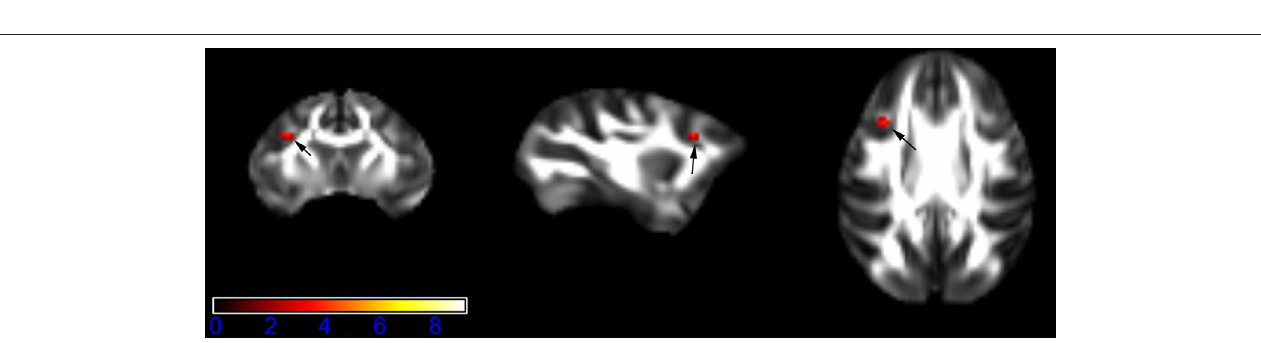
FIGURE 4 | Areas in middle temporal gyrus WM (MTG-WM, left side) with reduced fractional anisotropy values in the chronic ketamine exposure group compared to controls at p < 0.005 (in red; uncorrected). The anatomical underlay is DTI-based monkey brain image template (UWRMAC-DTI271) FA map with white matter atlas. Figure from left to right side is coronal view, sagittal view, and axial view of the images, respectively. The color bar represents the t -value.